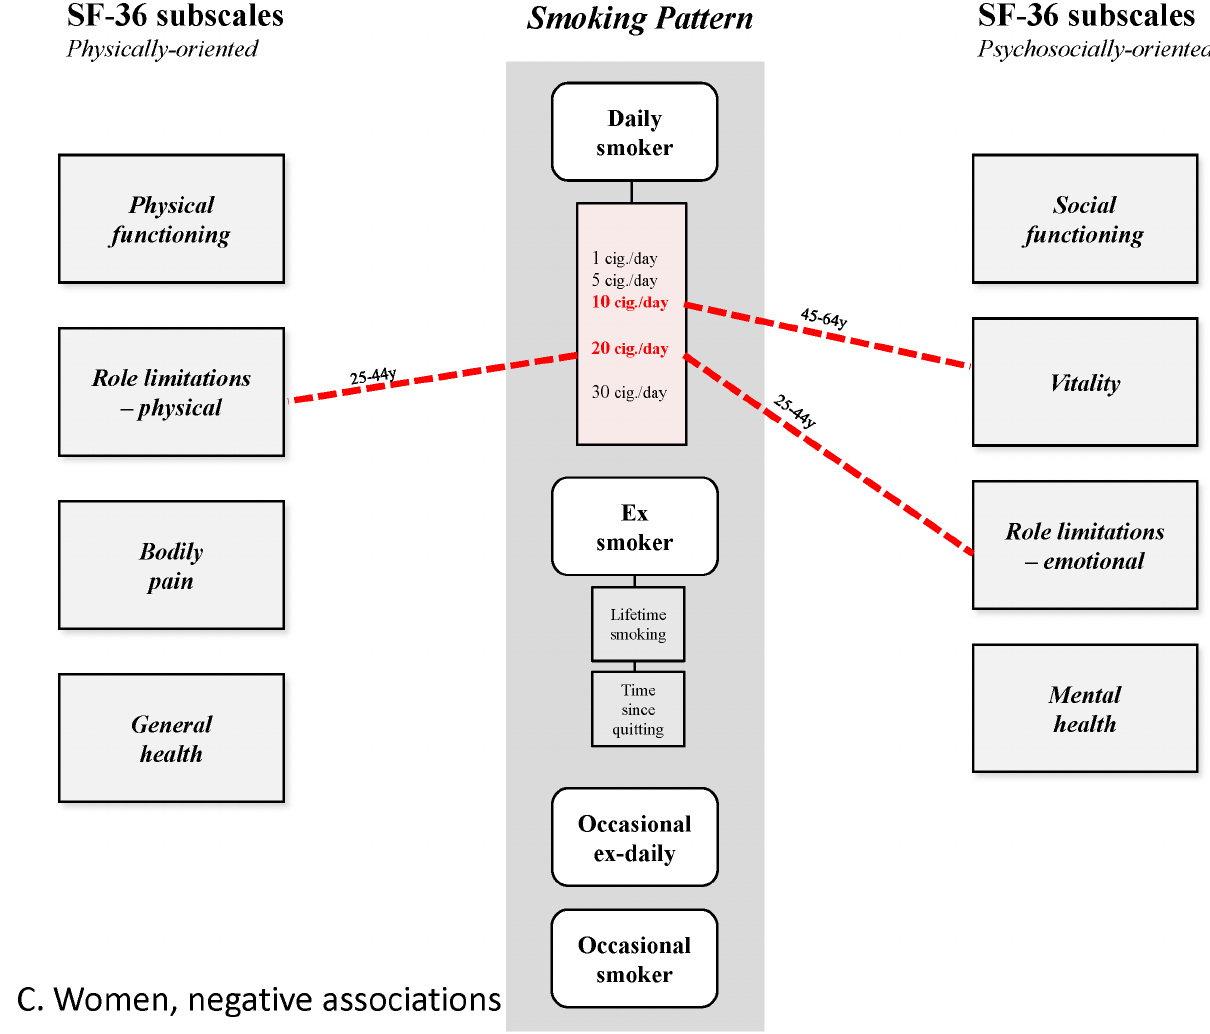
Figure 6. Patterns of relationships found in this study. Women, positive associations.